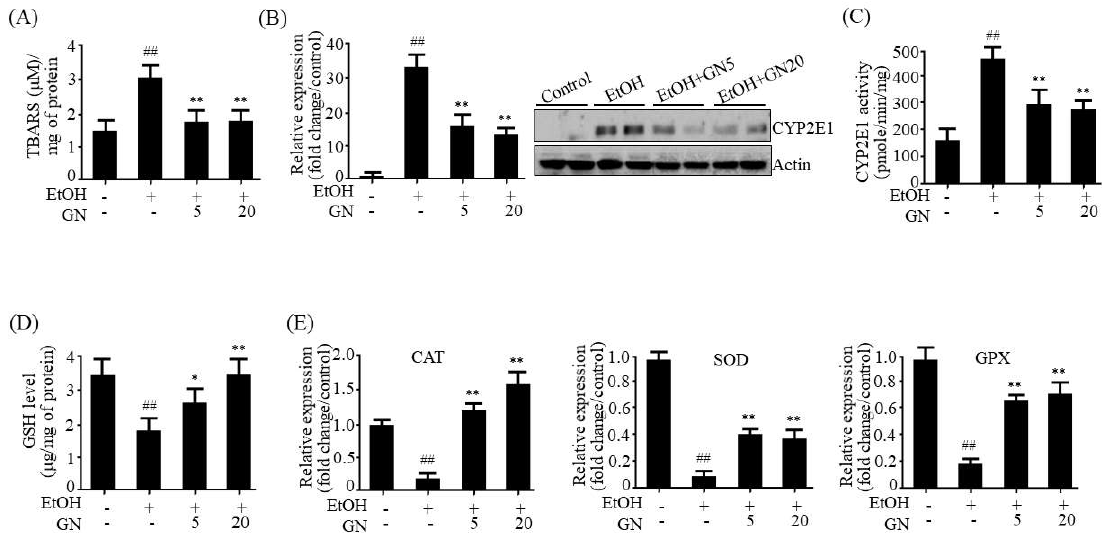
Figure 3. Gomisin N mitigates ethanol-induced oxidative stress in the liver of chronic-binge ethanol-fed mice. ( A ) Hepatic levels of TBARS (malondialdehyde (MDA)). ( B ) qPCR and western blot analyses of cytochrome P450 2E1 (m CYP2E1 ). ( C ) CYP2E1 enzyme activity. ( D ) Hepatic levels of glutathione (GSH). ( E ) qPCR analysis of catalase (m CAT ), superoxide dismutase (m SOD ), and glutathione peroxidase (m GPX ). Values are the mean ± SD ( n = 6). ## p < 0.01 vs. pair-fed control mice, * p < 0.05, ** p < 0.01 vs. ethanol-fed mice.